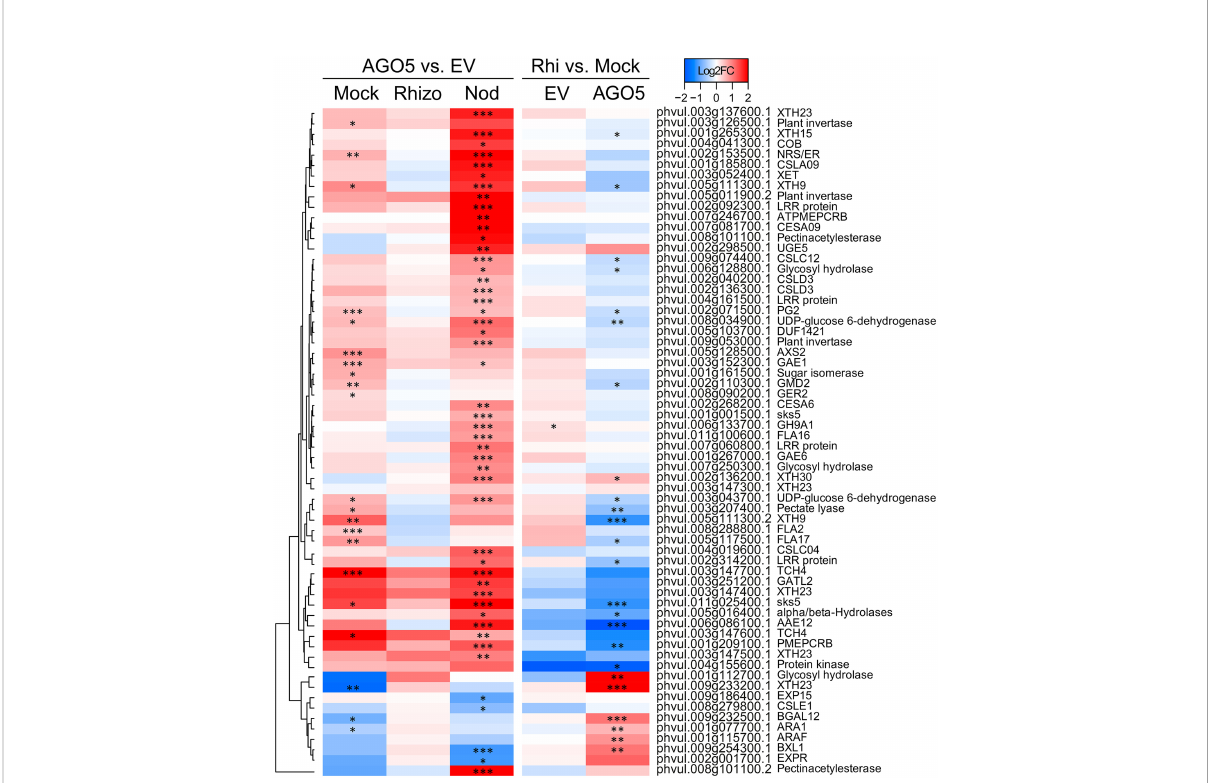
FIGURE 3 PvAGO5 modulates the expression of genes involved in the cell wall biosynthesis. Heatmap showing Log2 fold-change of gene transcripts involved in the biosynthesis and remodeling of the cell wall. Genes showing higher and lower expression difference are shown in different shades of red and blue, respectively. Labels at the top of the heatmap located on the left side indicate: Mock= uninoculated transgenic roots; Rhizo= rhizobia-inoculated transgenic roots, and Nod = mature nodules. In both cases the comparison between PvAGO5- RNAi vs Empty Vector is shown. Labels at the top of the heatmap located on the right side indicate: EV= transgenic roots expressing the empty vector (control), and AGO5: transgenic roots expressing the PvAGO5- RNAi construct. In both cases the comparison of rhizobia-inoculated roots vs mock- inoculated roots is shown. Asterisks indicate different levels of statistical signi fi cance of the comparisons (*: adjusted P-value<0.05; **= adjusted P-value<0.01; ***= adjusted P-value<0.001). Genes with no asterisk are not signi fi cantly differentially expressed. Dendrogram (left) represents the transcript clustering based on expression pro fi